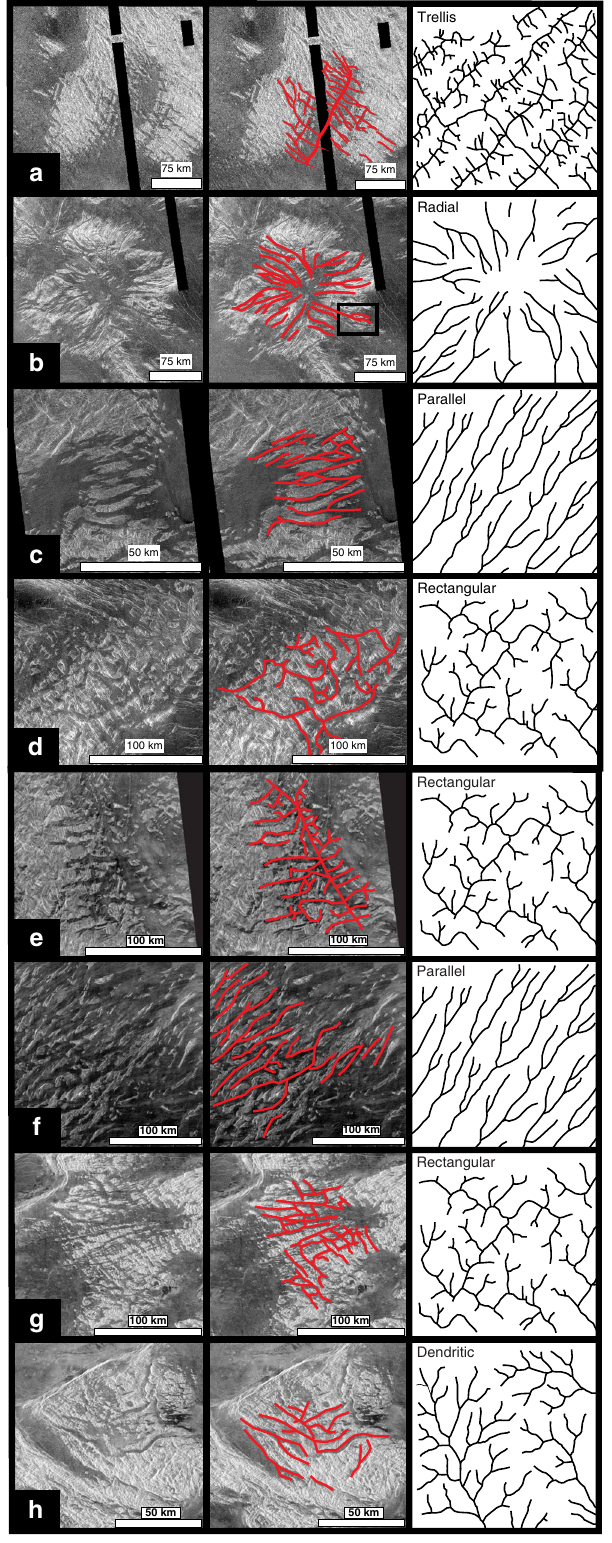
Fig. 3 Valley patterns revealed by lava fl ooding and our fl uvial interpretation. Shows tesserae regions that are partially fl ooded by lava fl ows and our interpretation of the resultant patterns in terms of stream drainage patterns. Each row features a Magellan SAR image (left) on which an interpreted valley pattern is drawn based on the volcanic fl ooding (centre) and which is matched to terrestrial stream drainage patterns (right). Types of stream drainage on Earth are after Howard (1967) 35 and Bridge and Demicco (2008) 36 . Centre location of SAR images: rows a (4.4°